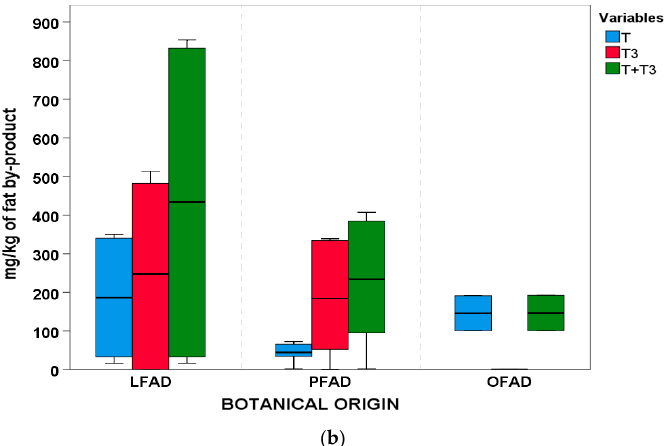
Figure 5. Tocopherols (T), tocotrienols (T3), and T + T3 contents according to botanical groups for ( a ) acid oils (AO) from chemical refining ( n = 79) and ( b ) fatty acid distillates (FAD) from physical refining ( n = 13) (see Table 1 for abbreviations of botanical groups). Within each type of byproduct (AO or FAD) and variable, botanical groups bearing different letters (a–c) show significantly different medians ( p ≤ 0.05) according to Kruskal–Wallis test and stepwise multiple comparisons for independent samples. ° Outliers: samples with values between (Q3 + 1.5 × IQR) and (Q3 + 3 × IQR) or between (Q1 − 1.5 × IQR) and (Q1 − 3 × IQR). * Extreme outliers: samples with values above (Q3 + 3 × IQR) or below (Q1 − 3 ×